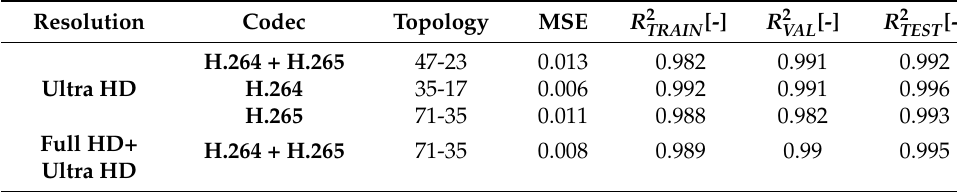
Table 9. Simulation of bitrate prediction based on MOS for the best topologies. Resolution Codec